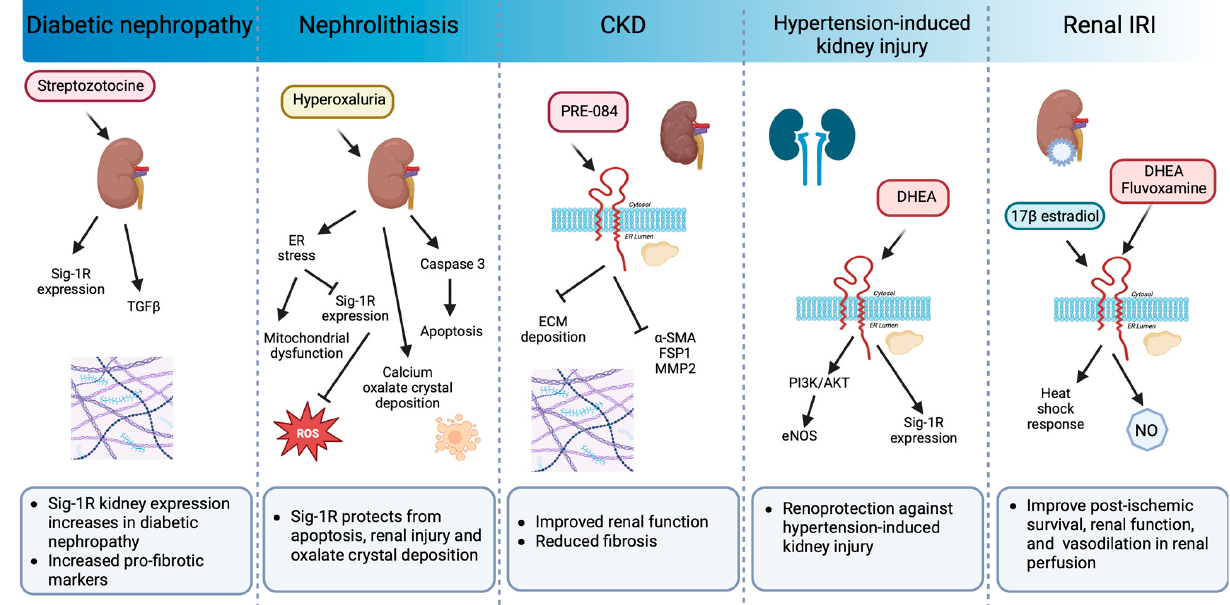
Figure 7. Sig-1R signaling in preclinical models of renal pathology. Sig-1R expression increases in diabetic nephropathy. Sig-1R protects from apoptosis, renal injury, and oxalate crystal deposition in a model of nephrolithiasis. Similarly, the administration of Sig-1R agonists improves renal function and reduces kidney injury and fibrosis in preclinical models of CKD, hypertension-induced kidney injury, and